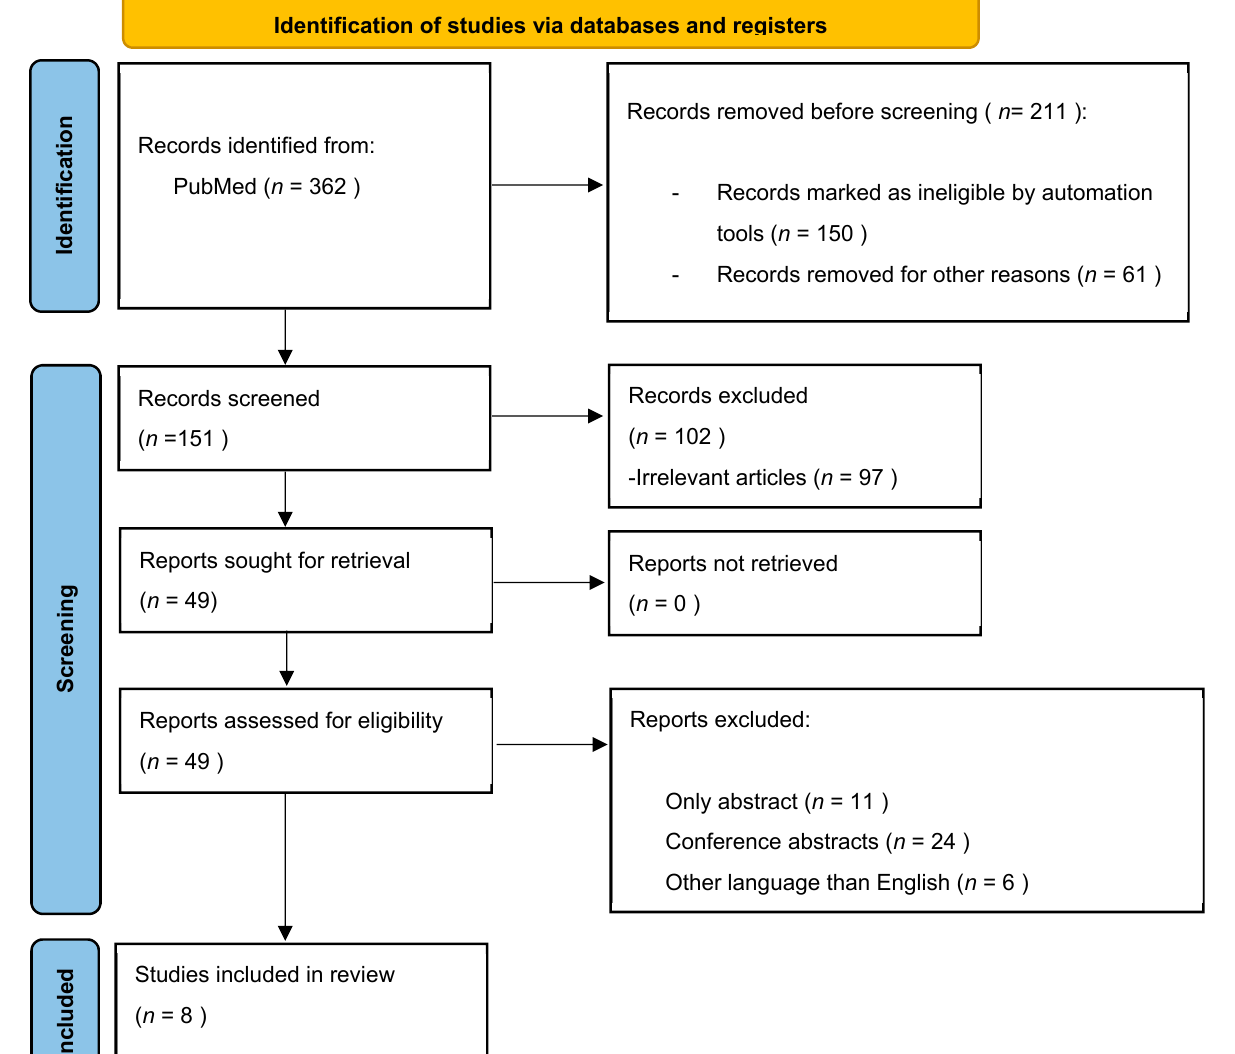
Figure 1. PRISMA flow diagram for study selection.